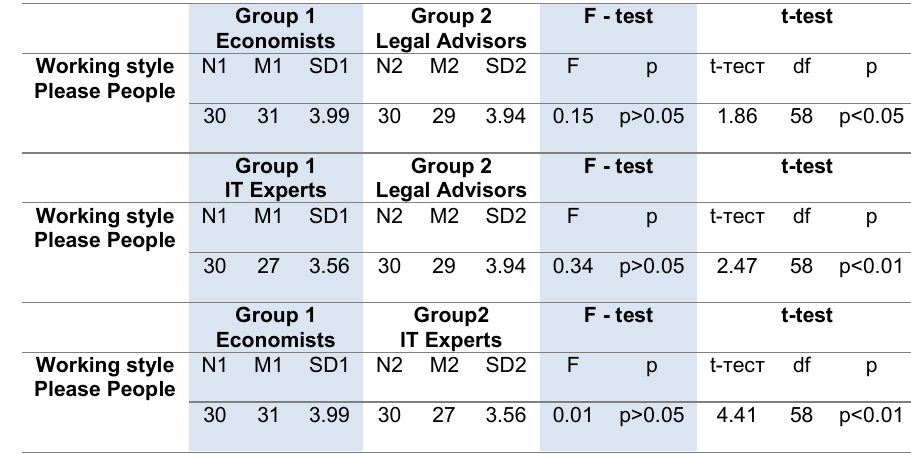
Table 5: Analysis of the differences between the three professions regarding the working style Please